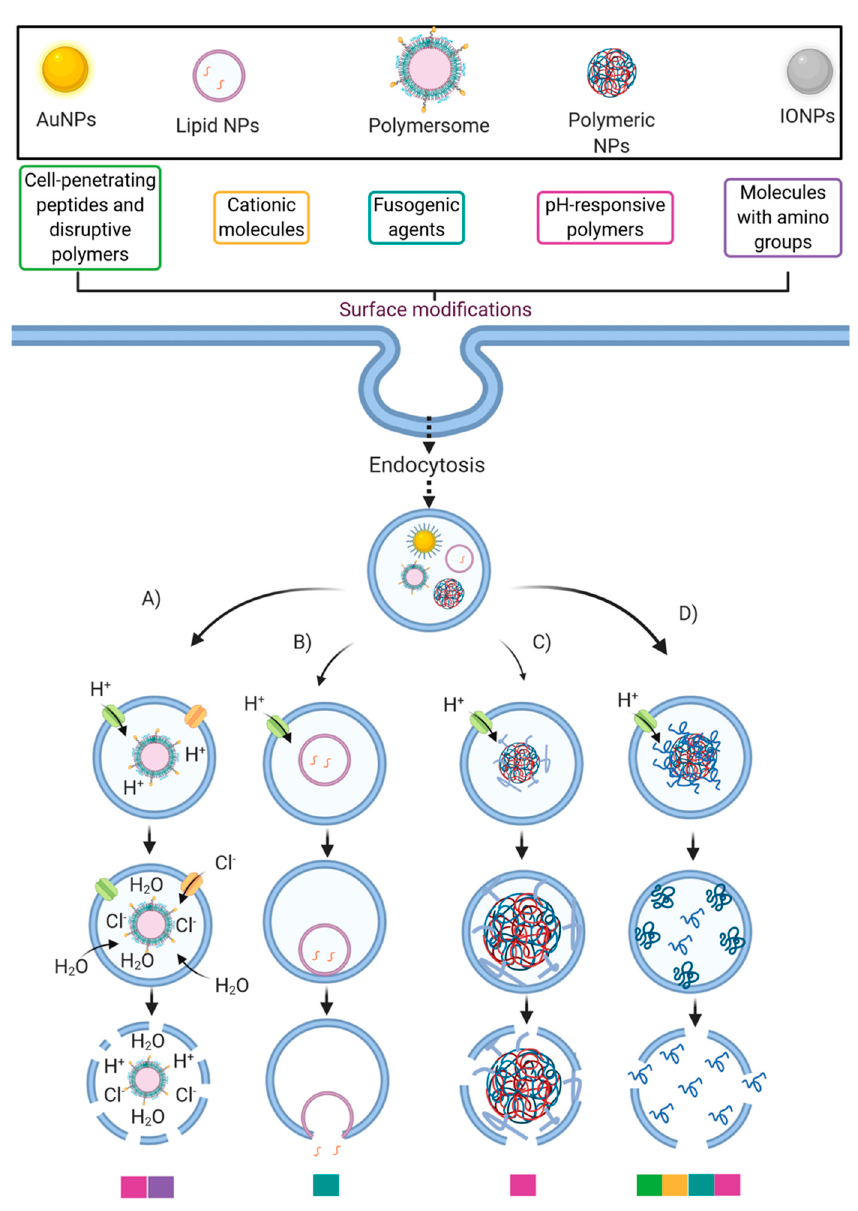
Figure 4. Strategies to improve the endosomal escape ability of some nanocarriers. This schematic illustrates the association between the more typically employed surface modifications and the endosomal escape mechanisms (EEMs): ( A ) Proton-Sponge and osmotic lysis; ( B ) Membrane fusion; ( C ) Particle swelling, and ( D ) Membrane translocation and destabilization. The color legend below the EEMs corresponds to the surface modifications that likely trigger the corresponding EEM. Created with BioRender.com. Table 1. Some ionizable lipids employed in the production of liposomes for gene silencing.